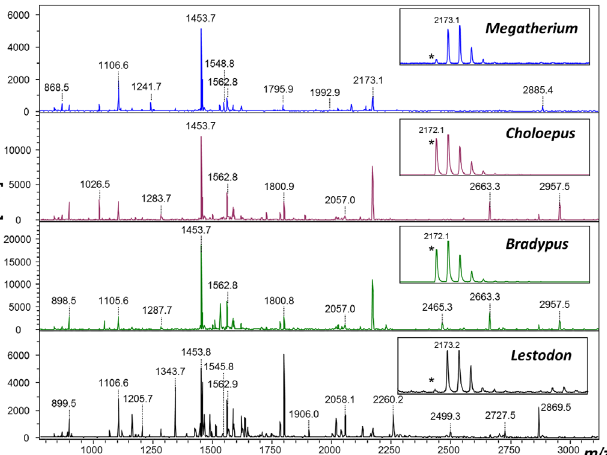
Fig 1. MALDI-ToF mass spectra of collagen extracted from Lestodon and Megatherium digested with trypsin. * Note the clearly observable difference in deamidation as a marker for protein ageing due to the presence of a glutamine residue in this peptide.